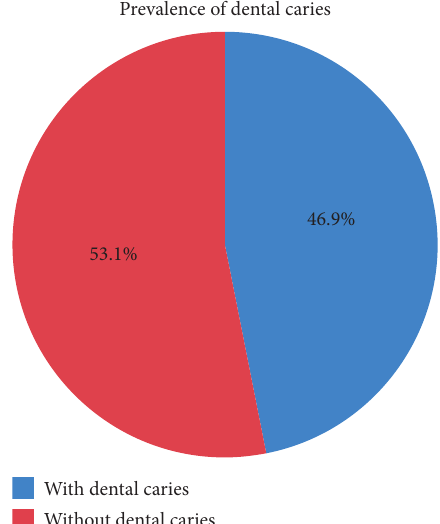
Figure 1: The prevalence of dental caries among primary school children in Alem Ketema, North Shewa, Ethiopia, Table 4: Factors associated with dental caries among primary school student in Alem Ketema town, North Shewa, Ethiopia, 2020. Variables